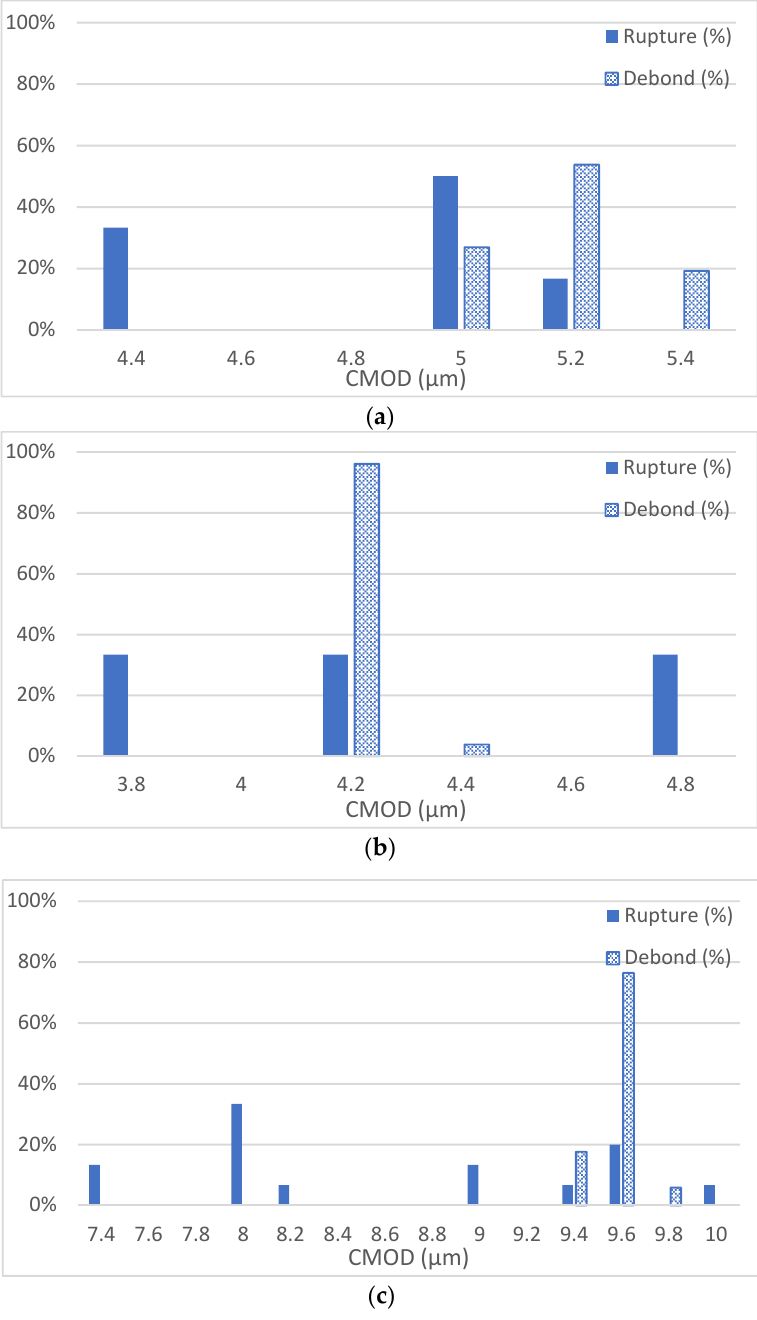
Figure 5. CMOD and capsule failure modes for the three mortar mixes, ( a ) 2 d without SCMs, ( b ) 2 d with SCMs, and ( c ) 28 d without SCMs.